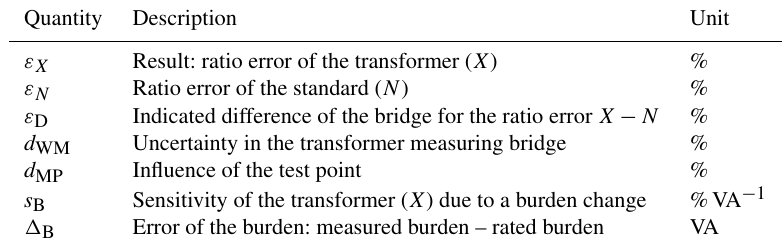
Error of the burden: measured burden – rated burden VA